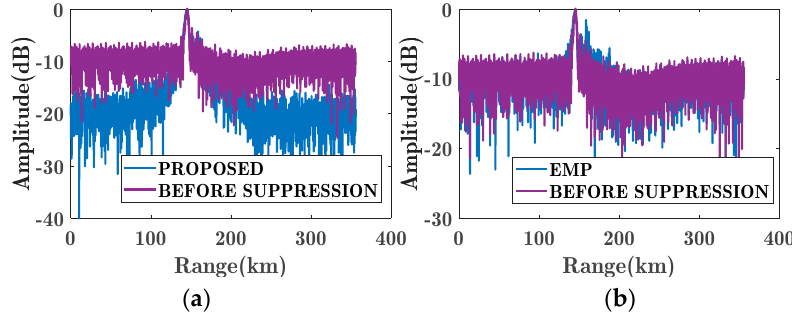
Figure 18. Results of SNR output in one direction: ( a ) proposed method; ( b ) EMP